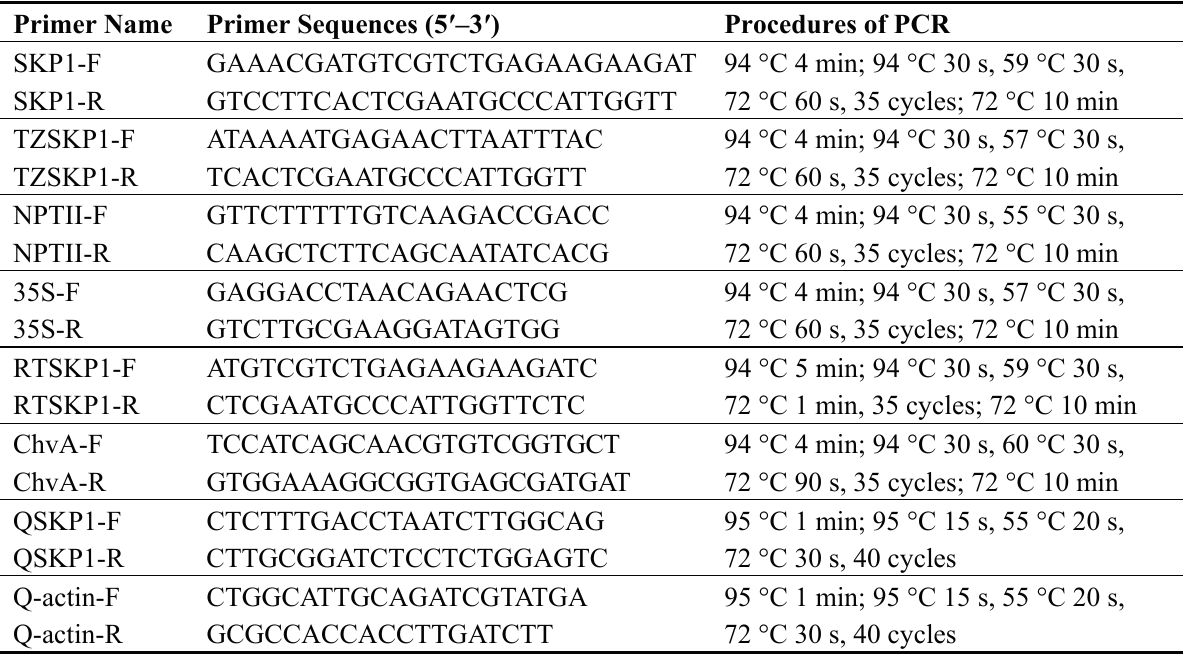
Table 1. Primer sequences and PCR procedures used in this